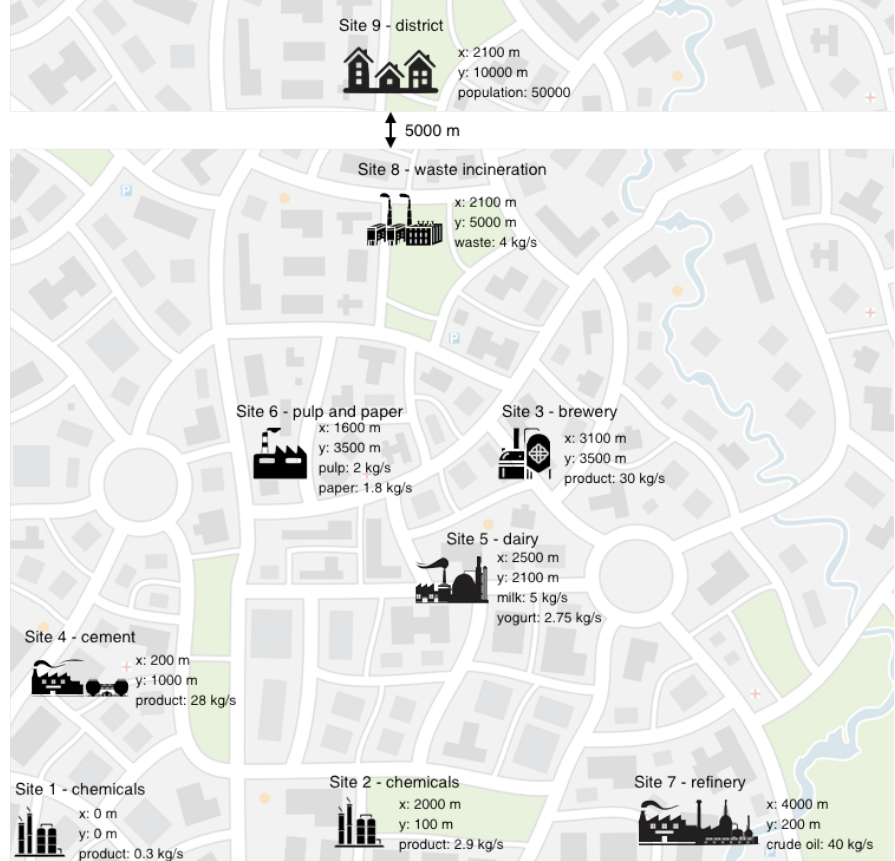
Figure 5. Layout of the industrial cluster neighbouring a